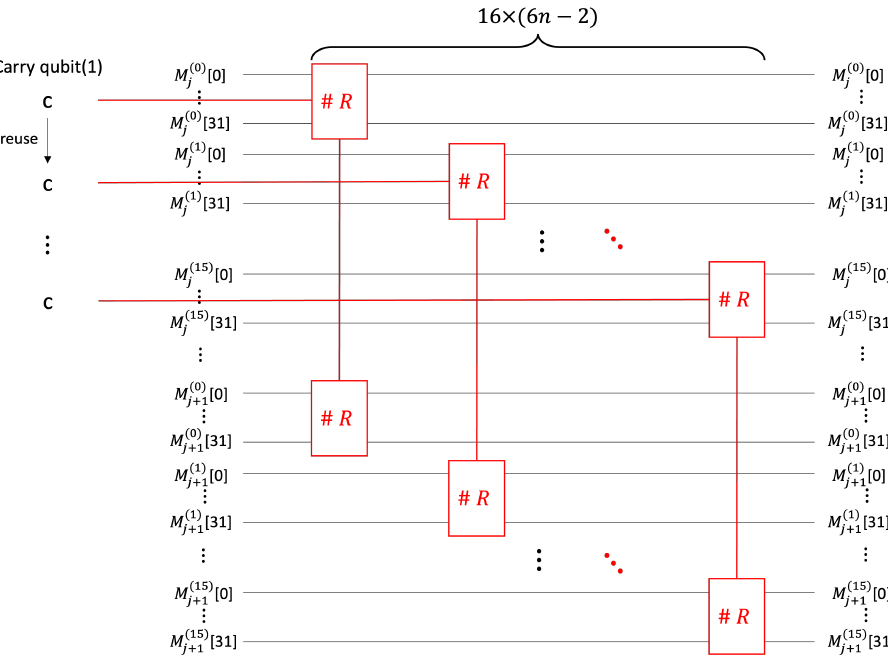
Figure 5. Sequential addition in MsgExp function. (Depth: 16 × (6 n − 2)).